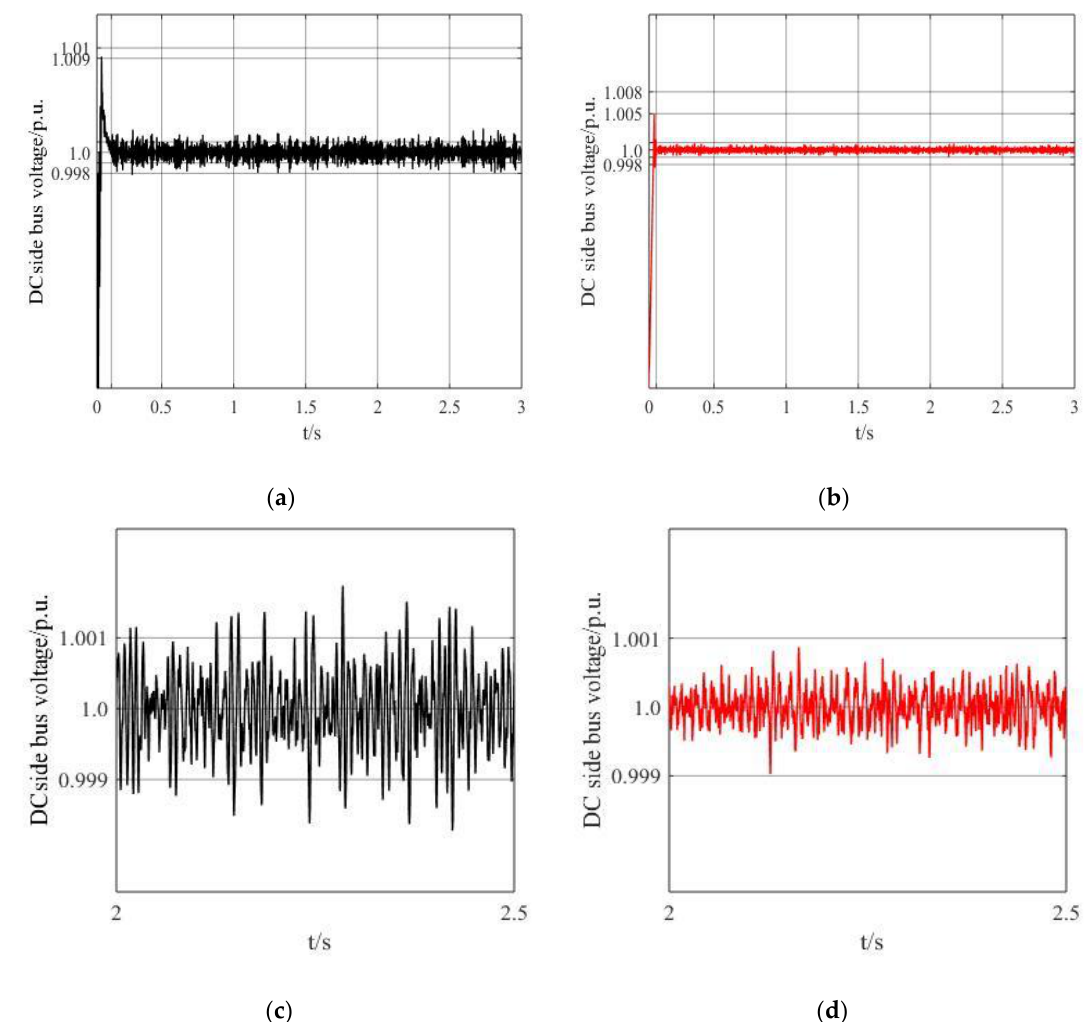
Figure 8. Contrastive of DC side bus voltage waveform under two control modes during steady operation. ( a ) traditional control mode; ( b ) second-order LADRC control mode; ( c ) DC side bus voltage fluctuation range under traditional control mode; ( d ) DC side bus voltage fluctuation range under second-order LADRC control mode.